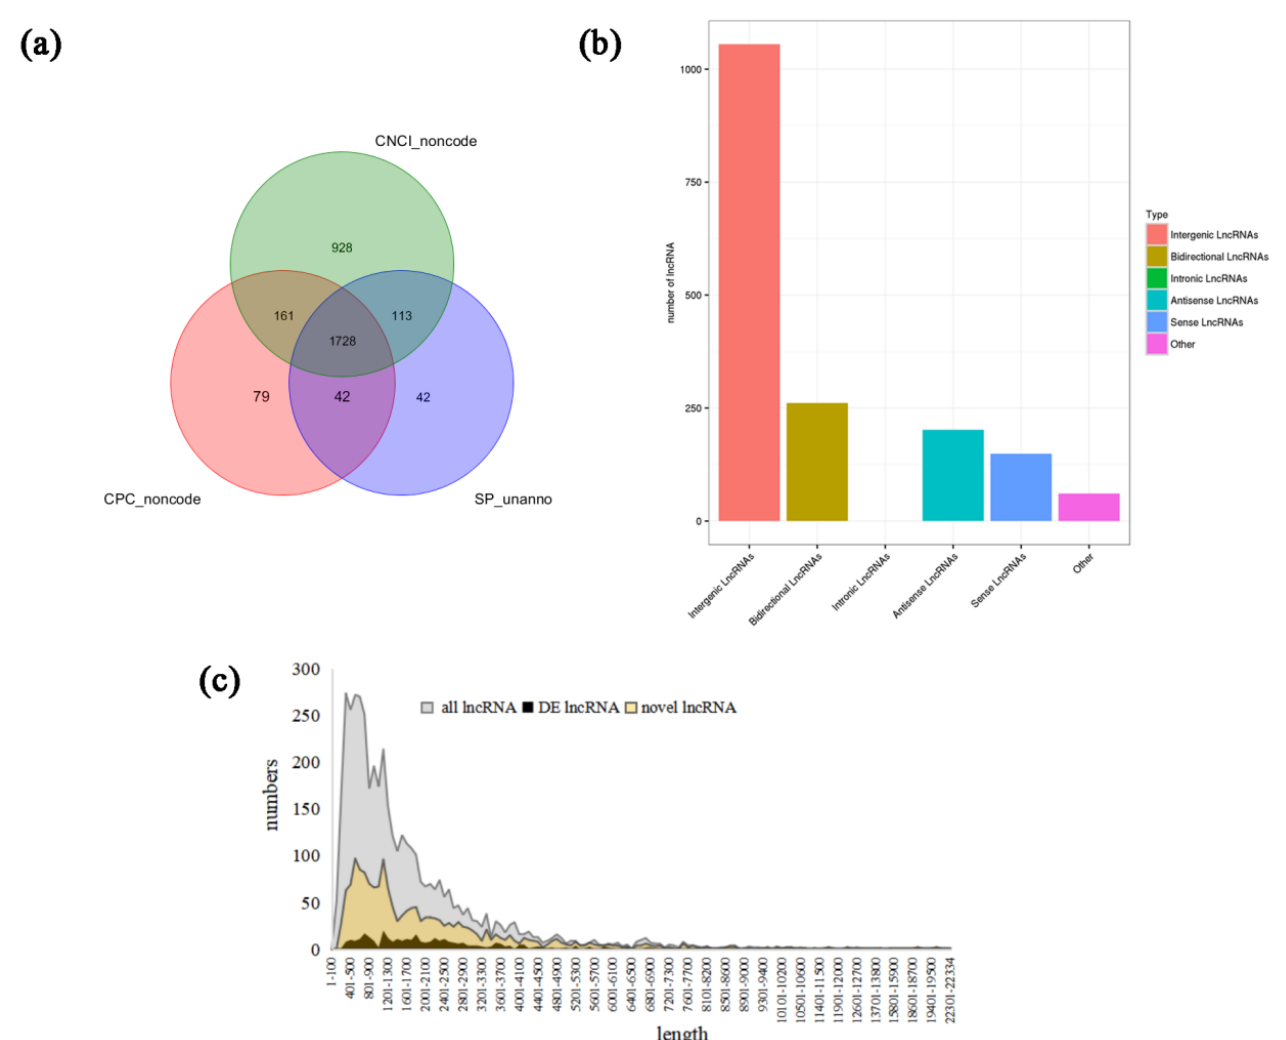
Figure 1. Prediction results for new lncRNAs and the statistics of new lncRNA types and lengths. ( a ) Prediction results of new lncRNAs, ( b ) Statistics of lncRNA transcript types, and ( c ) Length statistics of lncRNAs.